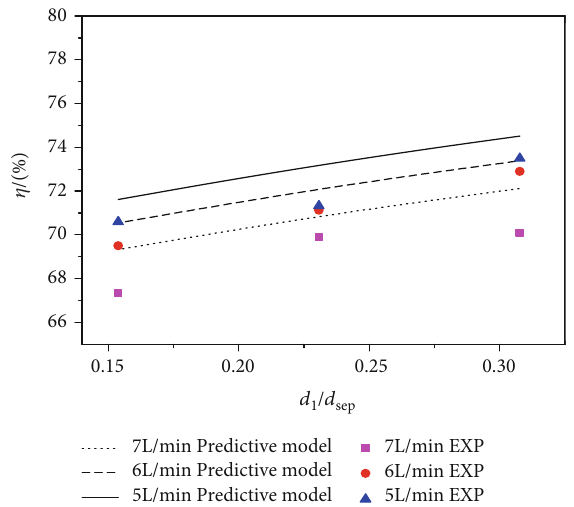
Figure 6: Comparison of separation e ffi ciency at di ff erent outlet trachea